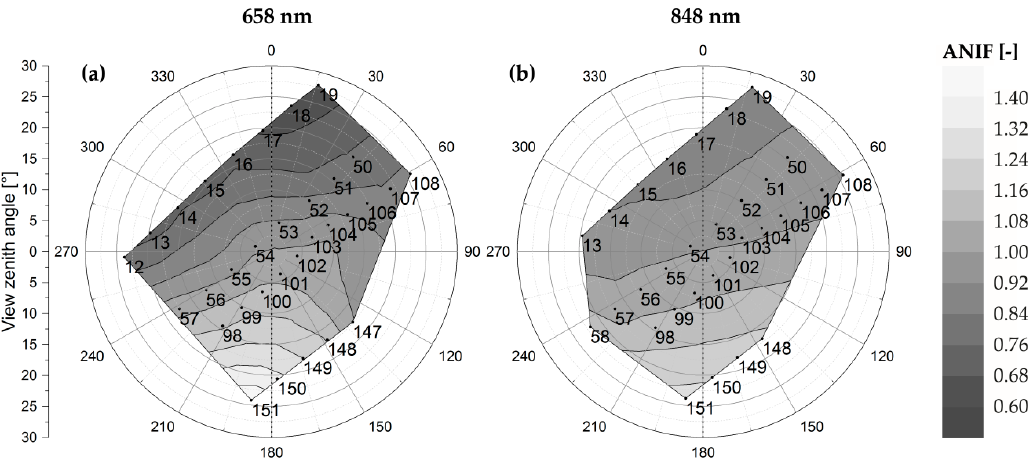
Figure 5. Linearly interpolated polar plots of the (anisotropy factors (ANIFs) observed for the example pixel in Figure 4 at 658 nm ( a ) and 848 nm ( b ), respectively. The numbers indicate the camera positions and correspond to the numbers in Figure 4b. The azimuth angles are relative azimuth angles, where 0° is the forward scattering direction and 180° is the backward scattering direction. The vertical dashed line indicates the solar principal plane.